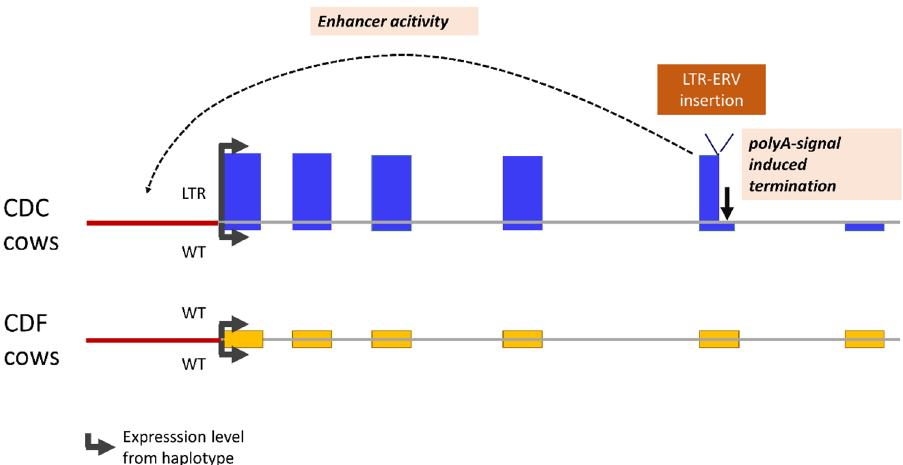
Figure 7. Model for modulated APOB expression due to ERV-K LTR insertion via combined enhancer activity and premature poly (A) signal insertion. Yellow and blue boxes indicate the expression levels for APOB